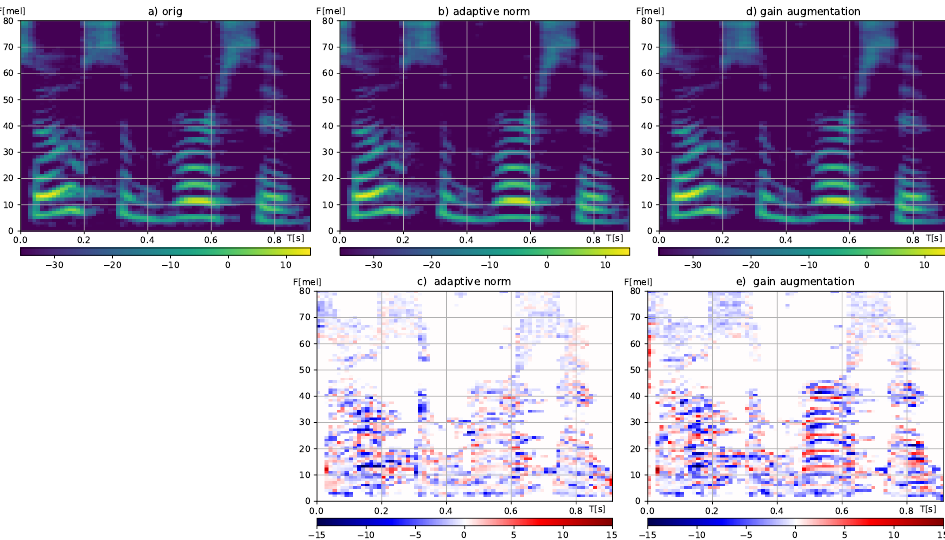
Figure 4. Comparison of mel spectrogram reconstruction errors for models trained with adaptive mel normalization and random gain augmentation on a short segment of a speech signal. ( a ) Mel spectrogram of original speech signal in dB. ( b ) Mel spectrogram after reconstruction with MBExWn model trained with adaptive normalization with smoothing window size α = 2 and one smoothing iteration. ( c ) Difference between ( a , b ). ( d ) Mel spectrogram after reconstruction with MBExWN model trained with random gain attenuation under gain augmentation with γ = 0.1. ( e ) Difference between ( a , d